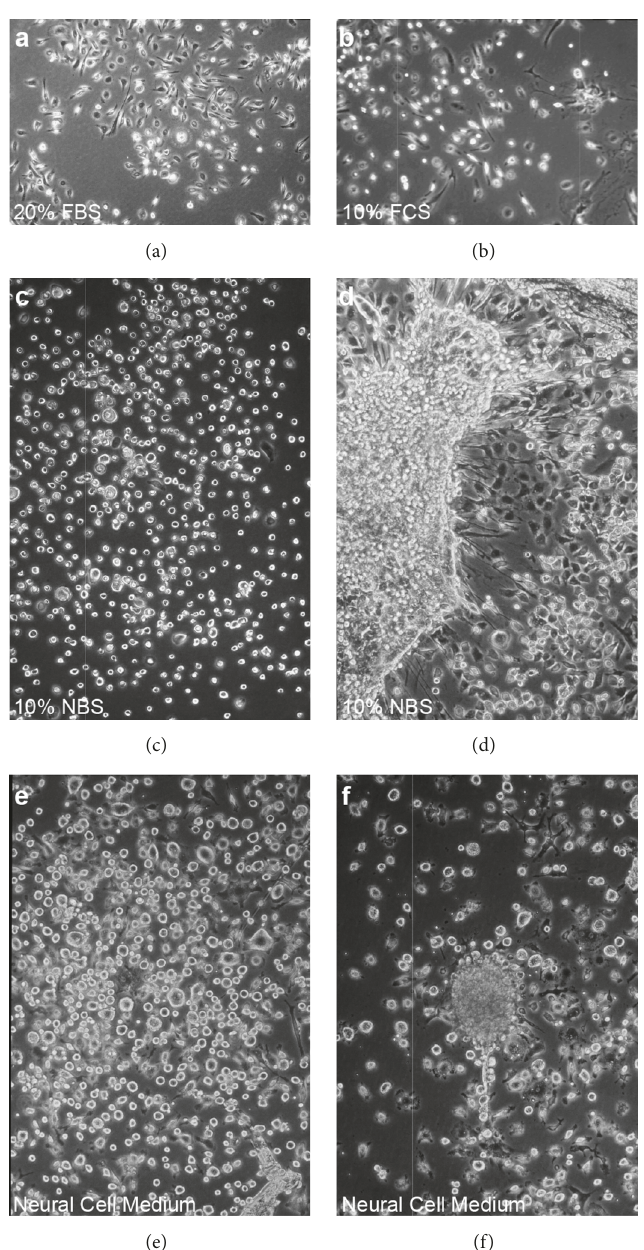
Figure 2: In vitro culture of mouse spleen cells in various media (1-4 weeks). Cells were cultured in DMEM/F12 containing 20% FBS (a), 10% FCS (b), or 10% NBS (c, d) or in neural cell medium (e, f). Round to oval shaped cells were dominant in the neural cell medium (e), and some formed spheres